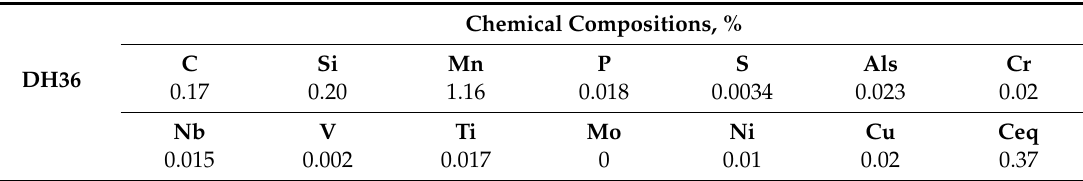
Table 1. Chemical compositions of DH36 steel.